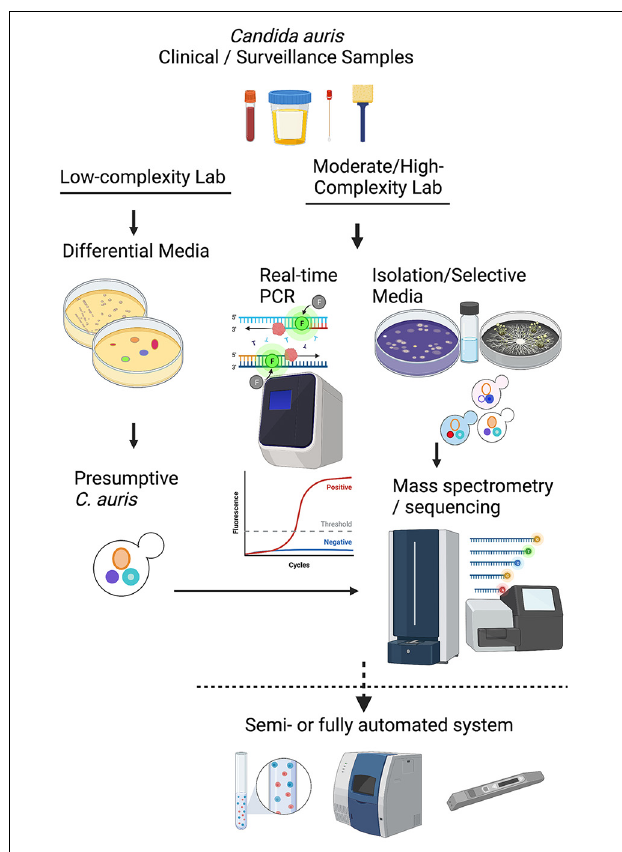
FIGURE 1 | A conceptual illustration of testing method differences between low-complexity and moderate- to high-complexity